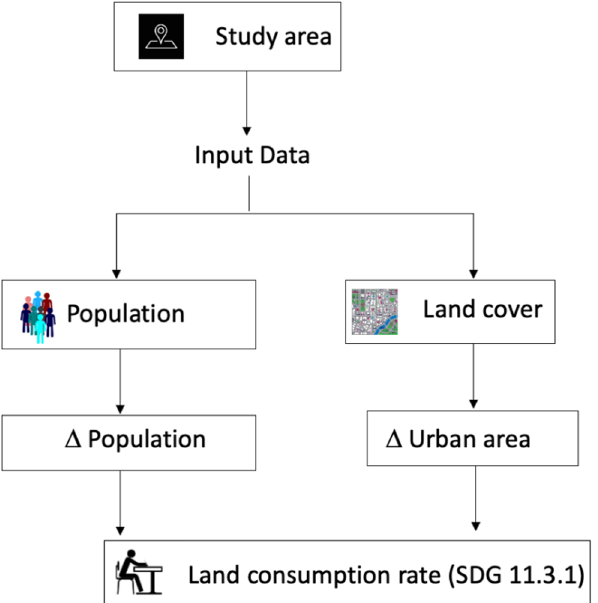
Figure 7. Workflow to measure land-consumption rate (SDG 11.3.1).